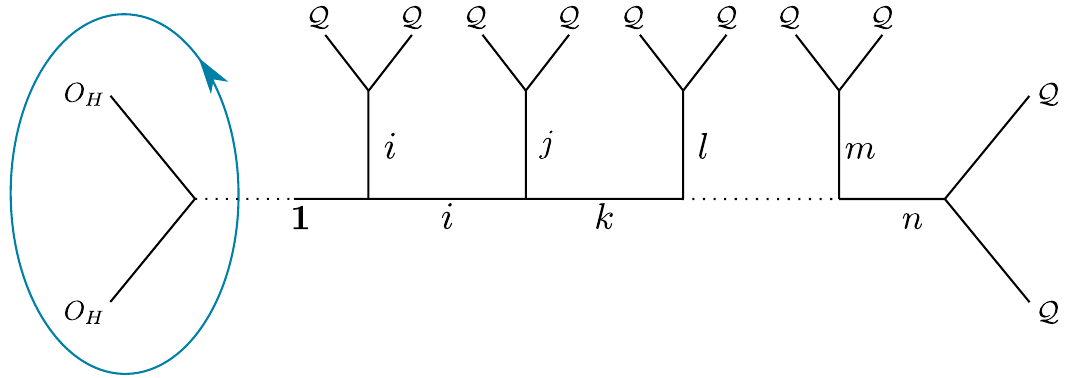
Figure 2: We will treat the operators as parametrically lighter than the O Q can then impose that the O fuse to the identity operator, which, to leading order H ( w → ∞ ) = O ( w − 4 ) results in ˜ T cl